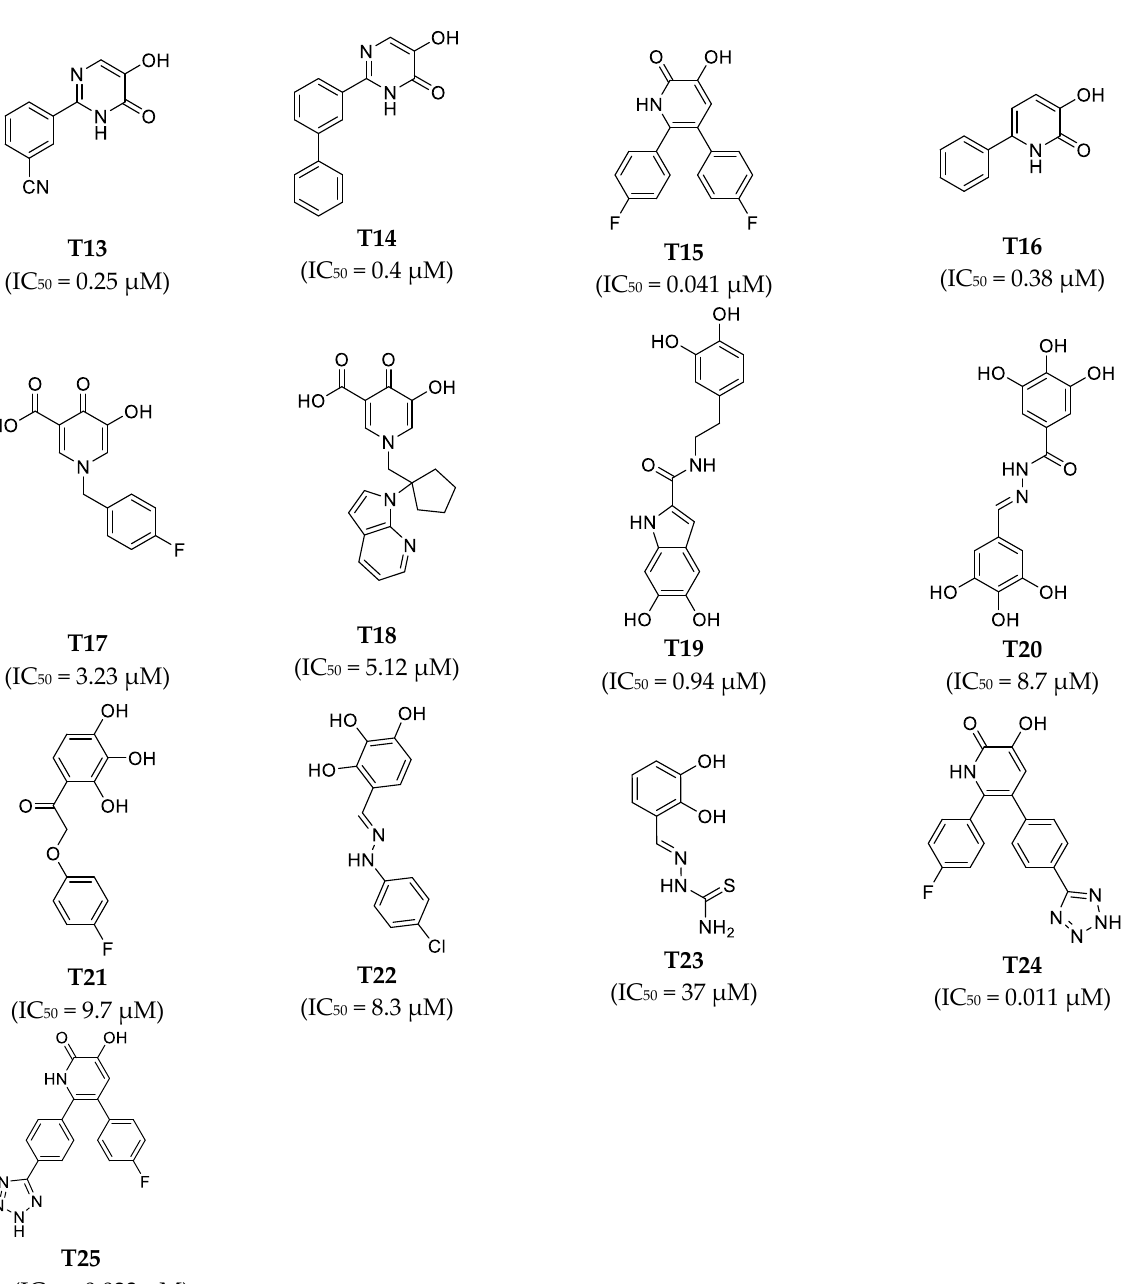
Figure 8. Chemical structures of PA N endonuclease inhibitors in the training set together with their biological activity data (IC 50 value, µ